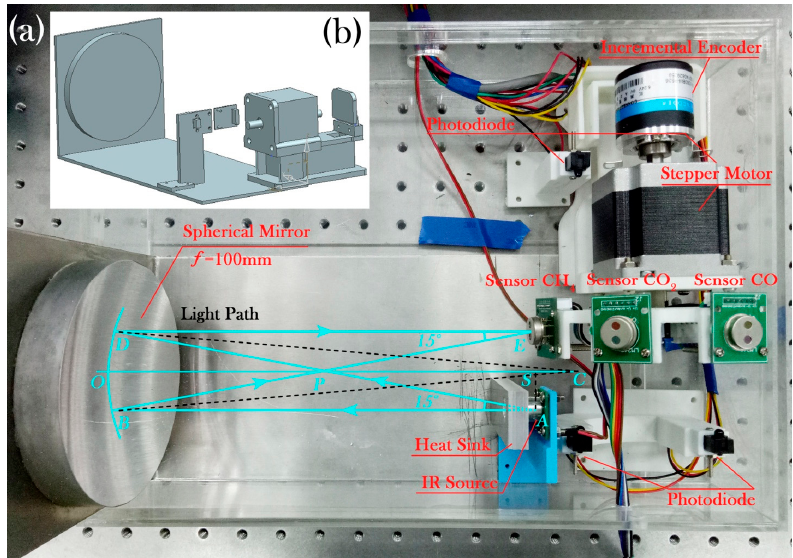
Figure 2. ( a ) Photograph of the optical part of the multi-gas sensor; ( b ) Computer Aided Design (CAD) model of the optical support frame.